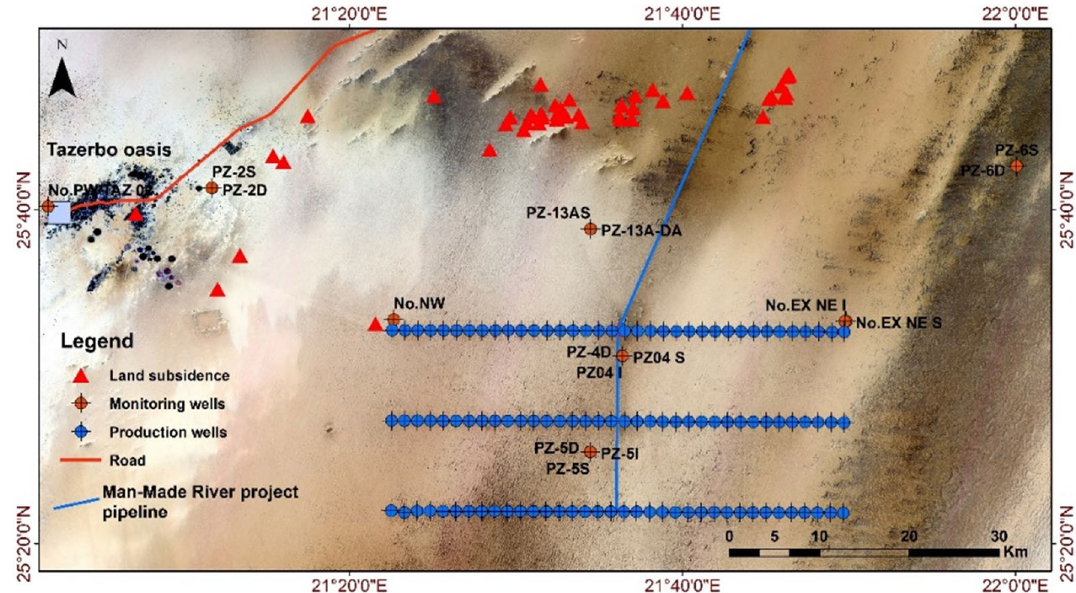
Fig. 8 Land subsidence location map (TCGM